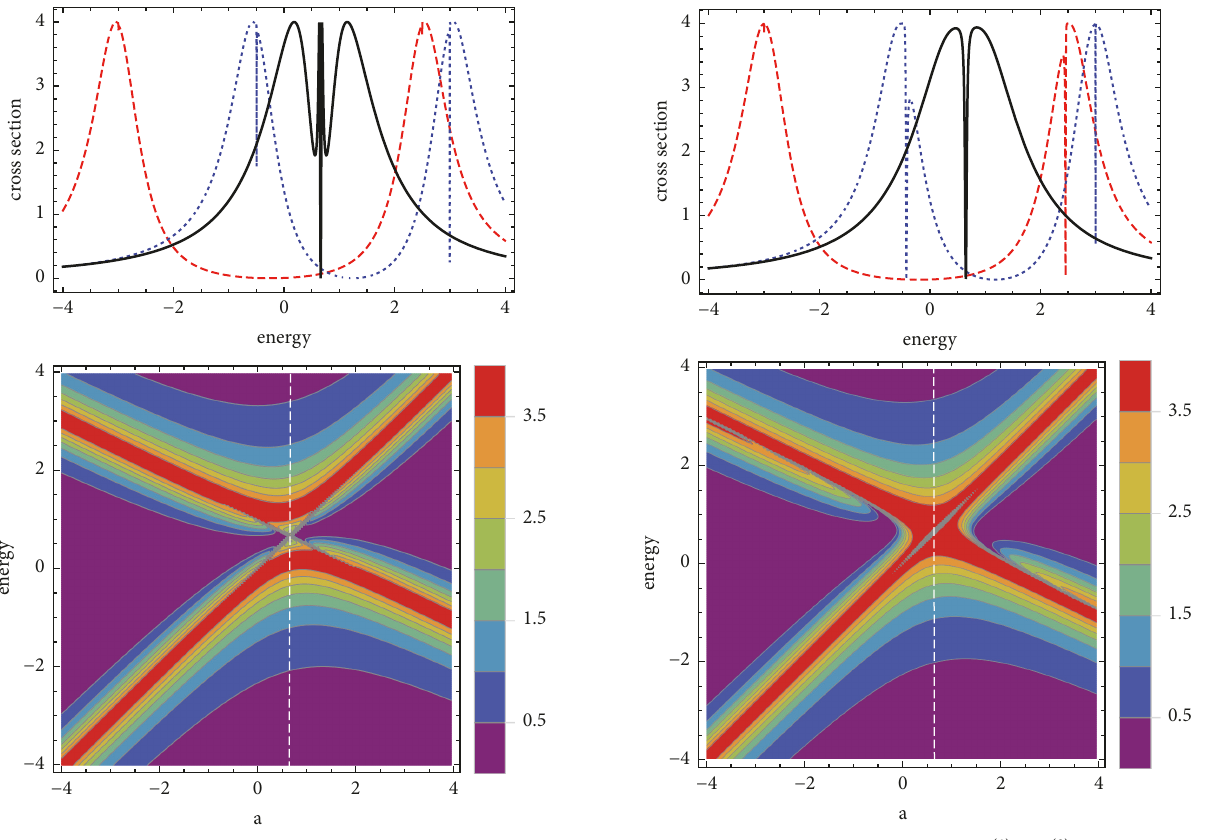
Figure 2: Resonance structure (above) and contour plot (below) of the transmission with 𝜔 (1) = 𝜔 (2) ̸= 0 . The parameters are the same as in Figure 1, left. Above: black: 𝑎 = 𝑎 cr ; red: 𝑎 1 = −3 ; blue: 𝑎 2 = 3 . Below: the white line marks the value 𝑎 = 𝑎 cr .